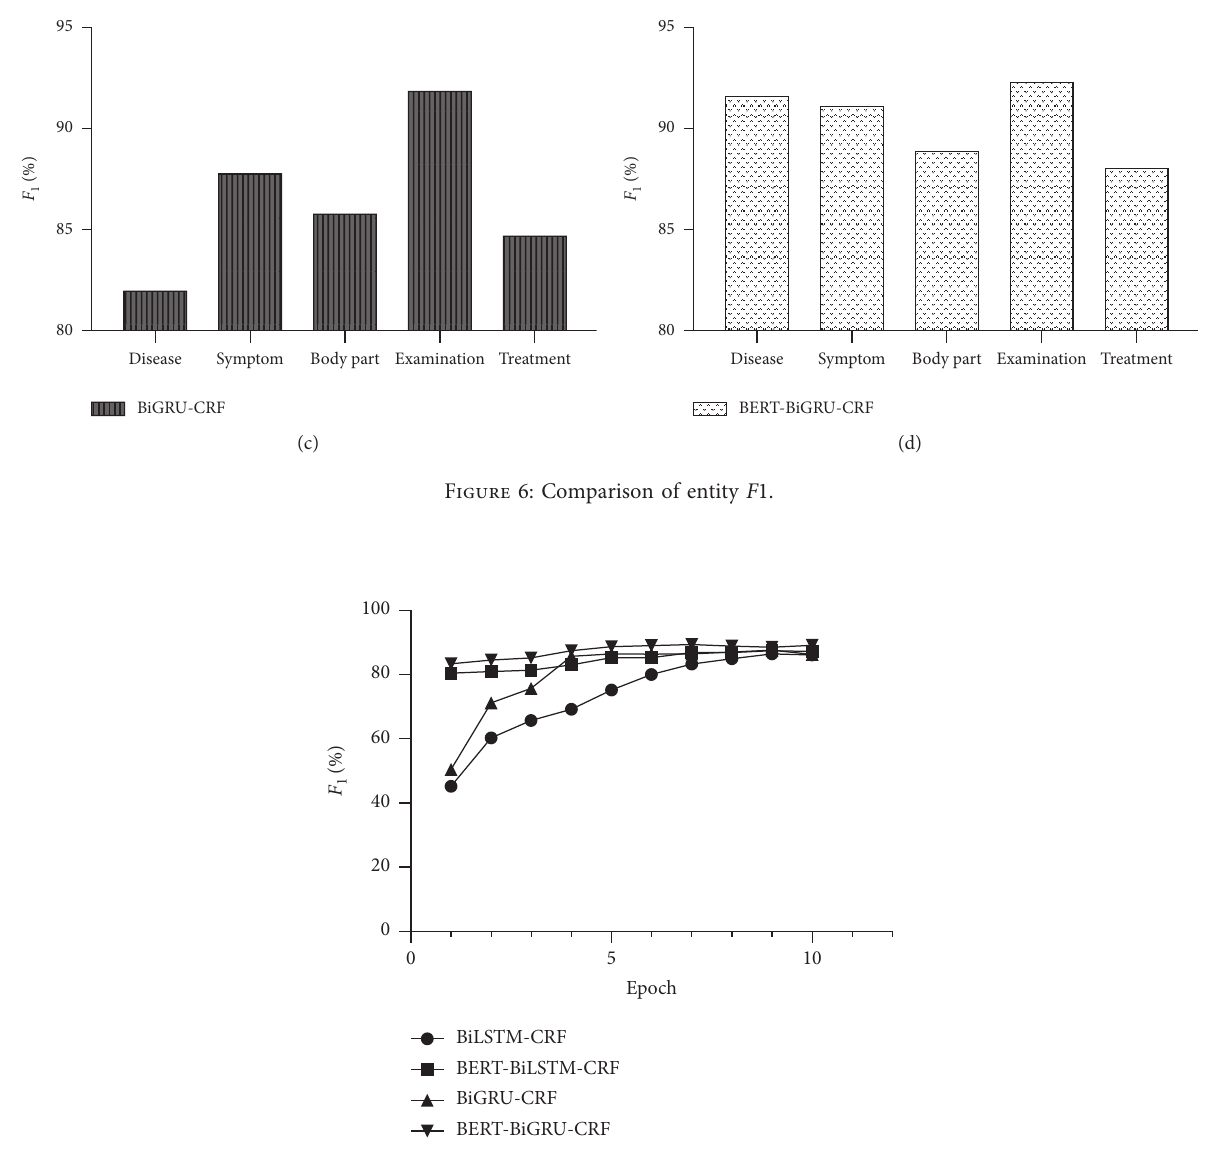
Figure 7: Epoch and F 1 relationship.